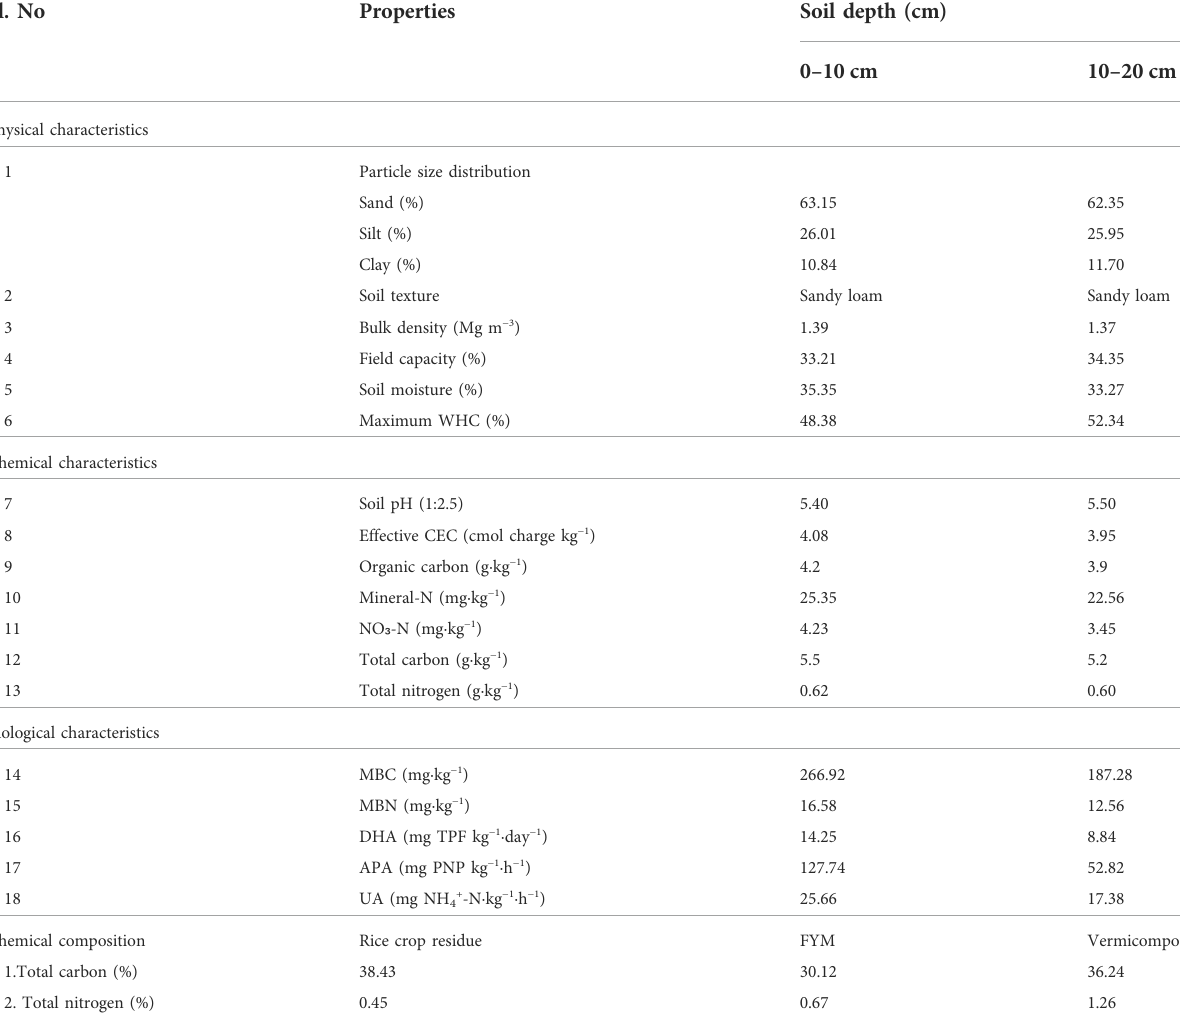
TABLE 1 Initial status of soil physicochemical and biological properties at the experimental site and characterization of organic amendments used in the experimental plot. Sl.